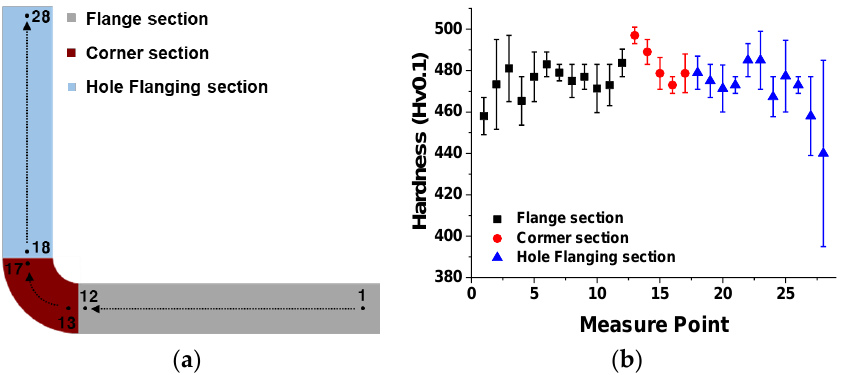
Figure 11. Hardness of hole-flanged samples; ( a ) hardness measurement positions; ( b ) hardness measurements with respect to position.